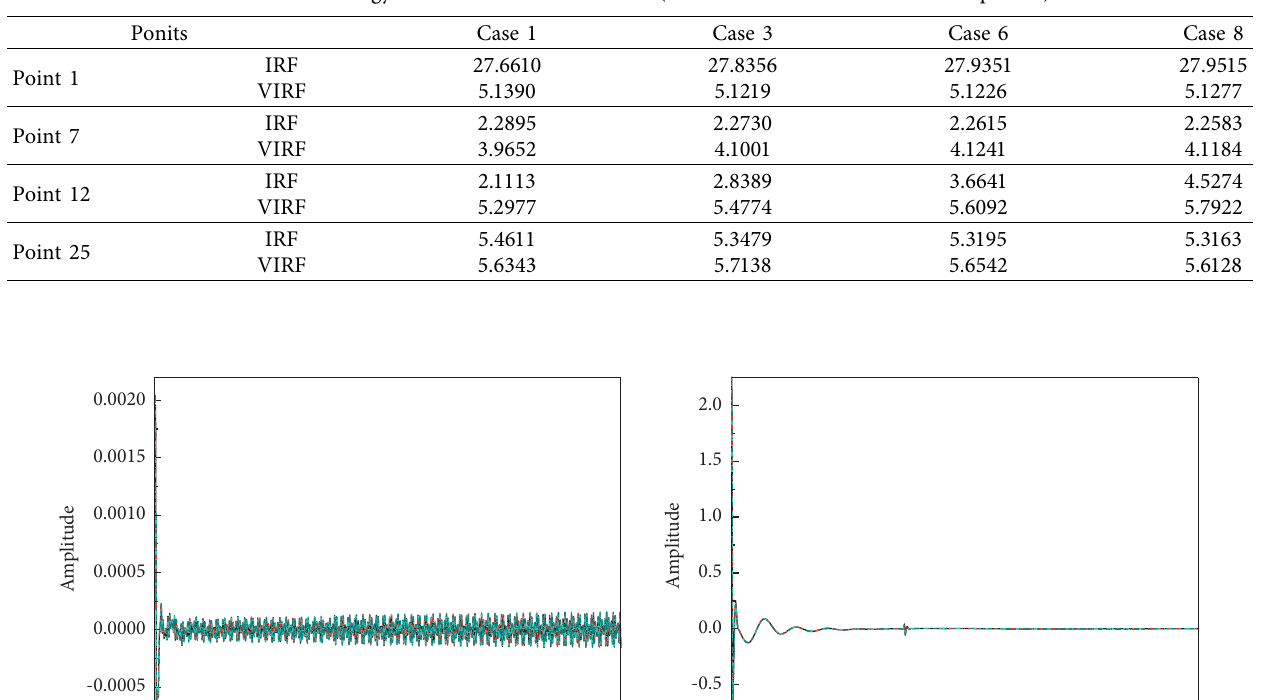
Table 6: The energy ratios of the residual bands (the second time test at excitation point I).